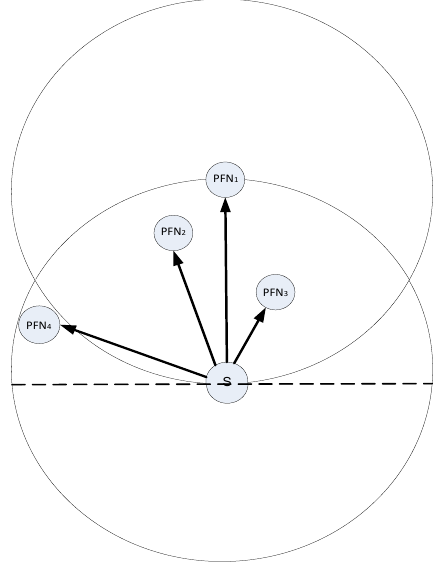
Figure 1. How duplicate packets are transmitted in opportunistic